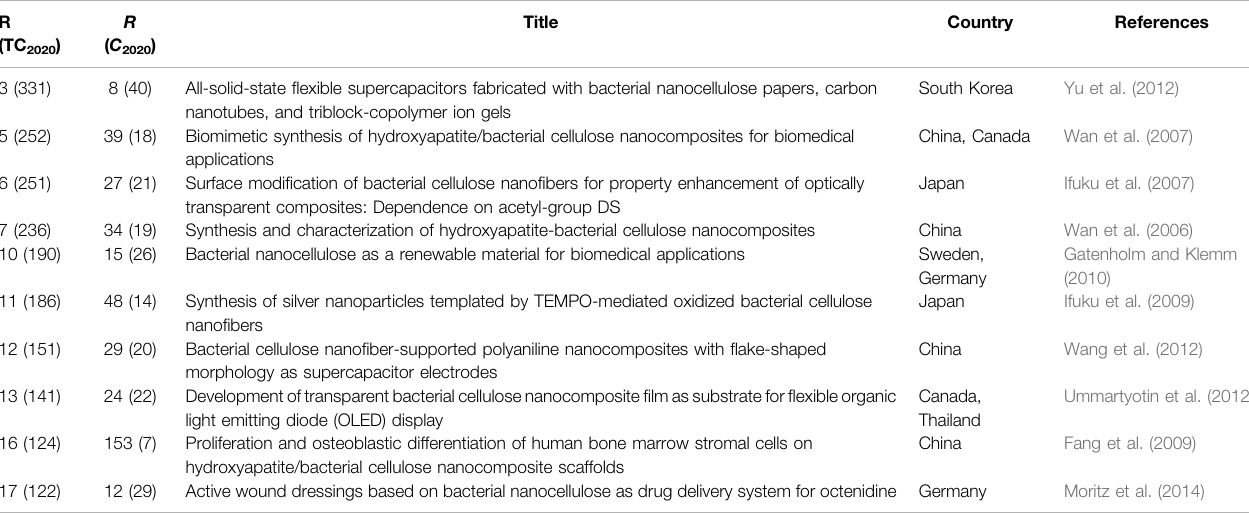
Frontiers in Bioengineering and Biotechnology |